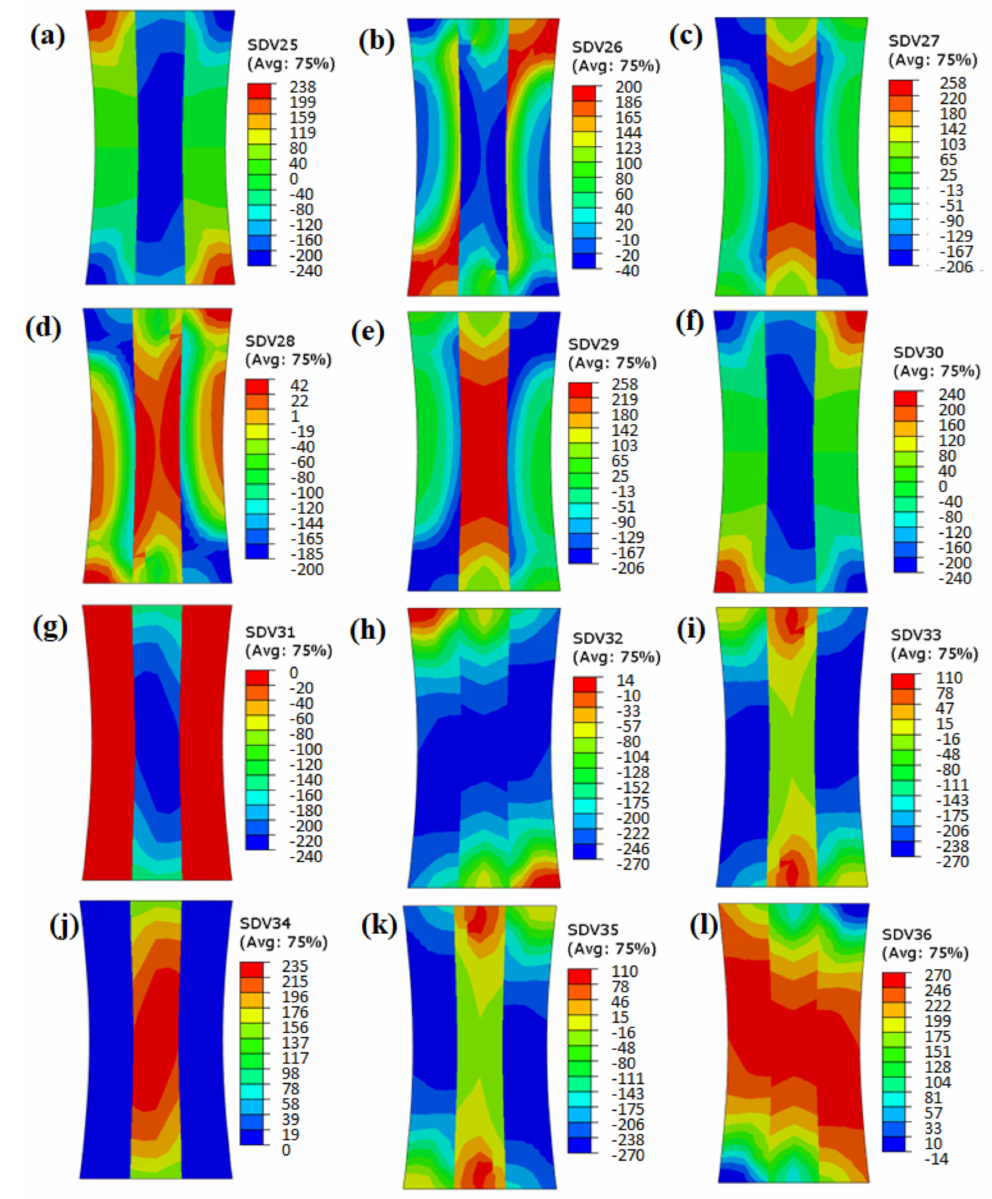
Figure 14. Shear stress of slip systems 1–12 with misorientation angle of 45 ◦ (SDV 25–SDV